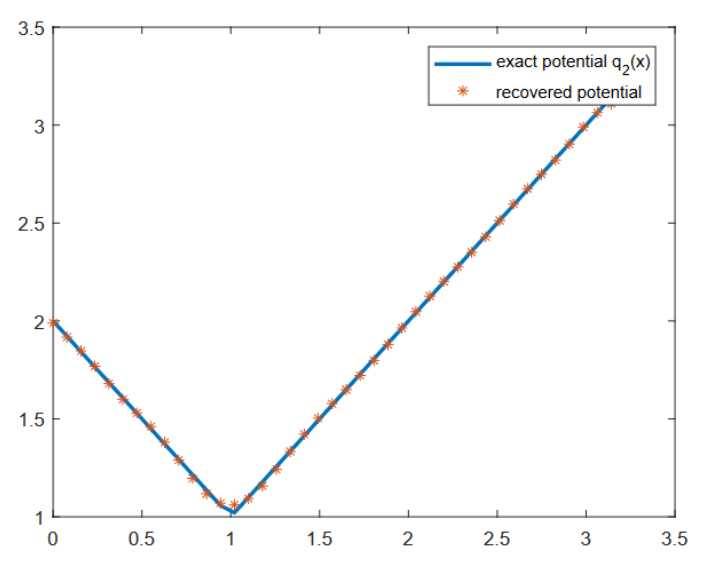
Figure 3. Potential q 2 ( x ) recovered from the data (8) with 25 points ρ k distributed uniformly on the segment in the complex plane [ − 1.5 + 0.1 i ,1.5 + 0.1 i ] , a ( k ) = sin ρ k and b ( k ) = cos ρ k , corresponding to l k , and N =